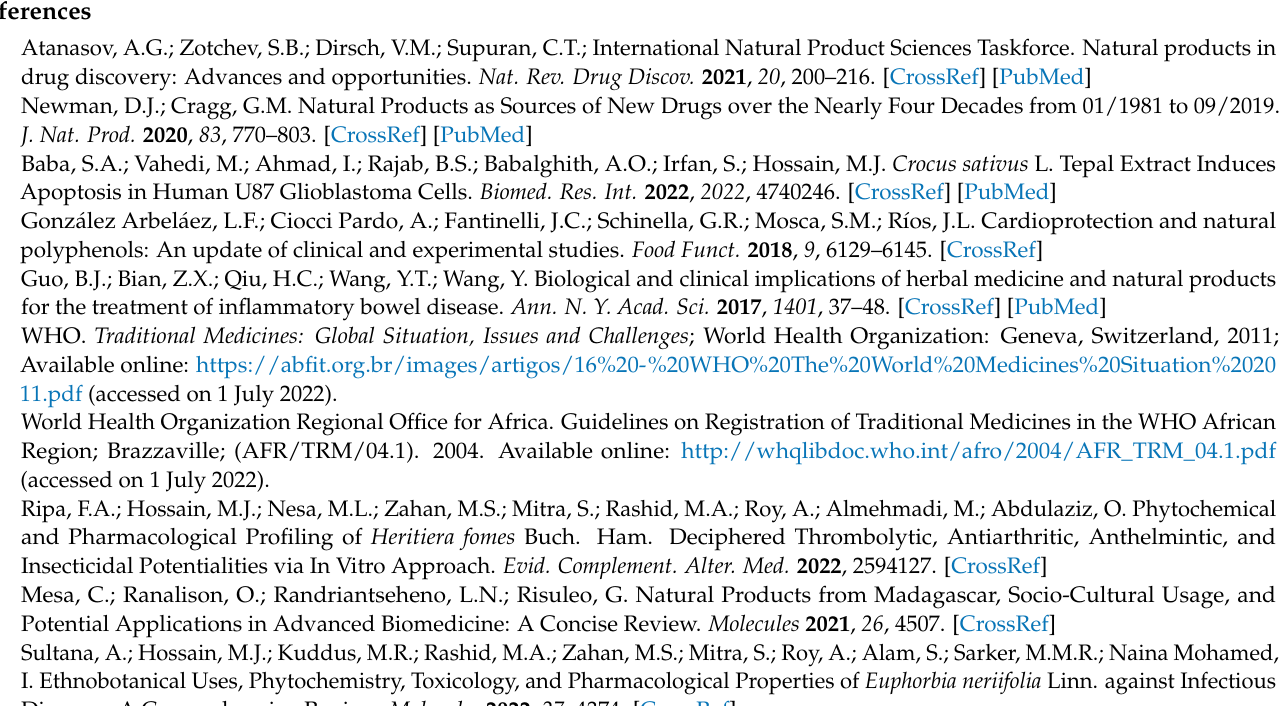
Table S6: The interactions of amino acids of the glucose transporter 3 (GLUT 3) (PDB ID: 4ZWB) with the isolated compounds ( 1 to 8 ) from Wendlandia tinctoria (Roxb.) DC. and the standard drug glibenclamide during molecular docking. Table S7: The interactions of amino acids of the kappa opioid receptor (PDB ID: 6VI4) with the isolated compounds ( 1 to 8 ) from Wendlandia tinctoria (Roxb.) DC. and the standard drug loperamide during molecular